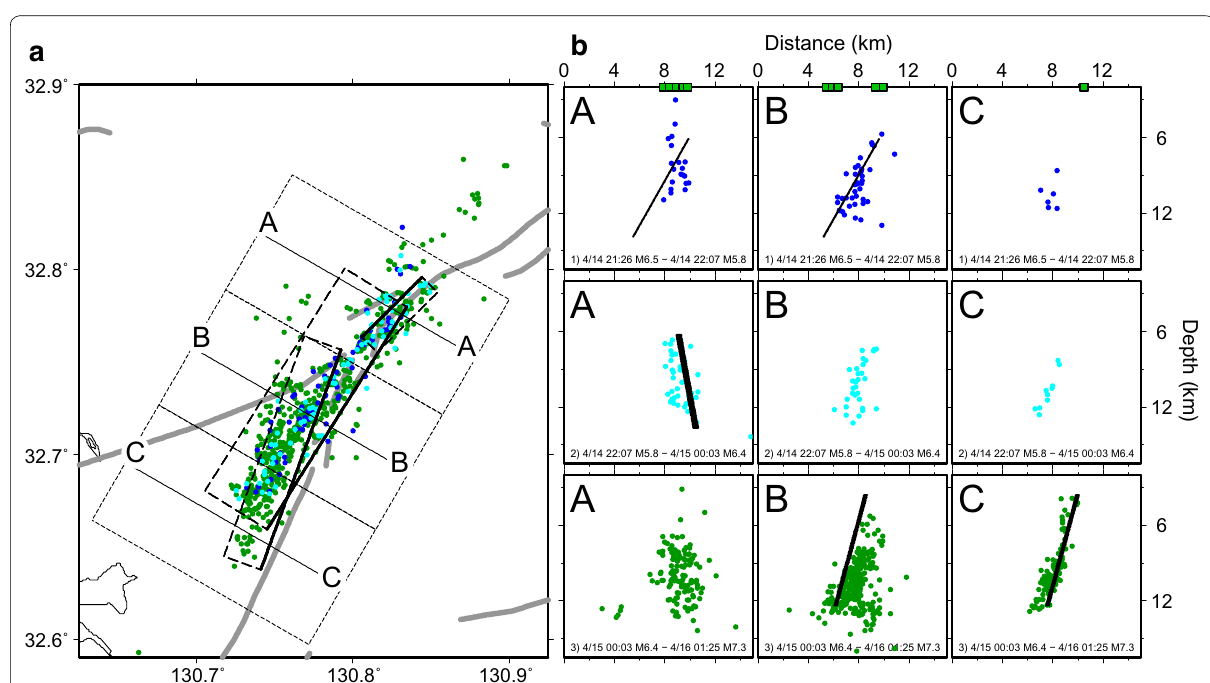
Fig. 3 Spatial distribution of the estimated fault planes of the foreshocks on a the enlarged map view of Fig. 2a and b the cross-sectional views. Blue, light blue, and green circles show the hypocenters for the periods between foreshocks 1 and 2 (top in ( b )), foreshocks 2 and 3 (middle in ( b )), and foreshock 3 and the main shock (bottom in ( b )), respectively. The estimated fault planes of the foreshocks (black lines) are the same as those shown in Fig.